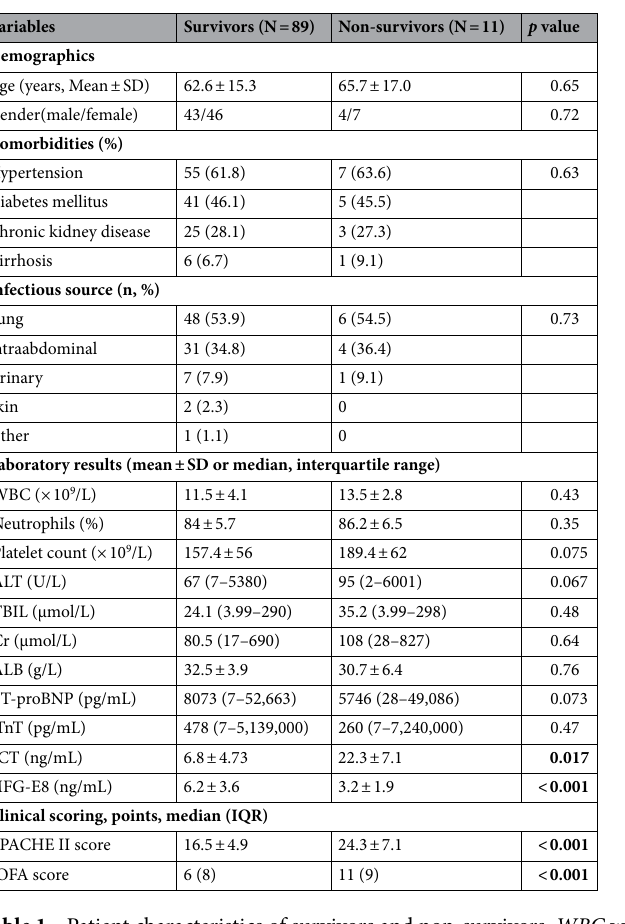
Table 1. Patient characteristics of survivors and non-survivors. WBC white blood cells, cTnT cardiac troponin T, NT-proBNP , NT-proB-type Natriuretic Peptide, ALT alanine transaminase, TBIL total bilirubin, Cr creatinine, ALB albumin, PCT procalcitonin, MFG-E8 milk fat globule epidermal growth factor 8, APACHE II score Acute Physiology and Chronic Health Evaluation II score, SOFA score Sequential Organ Failure Assessment Score. Significant values are in bold.